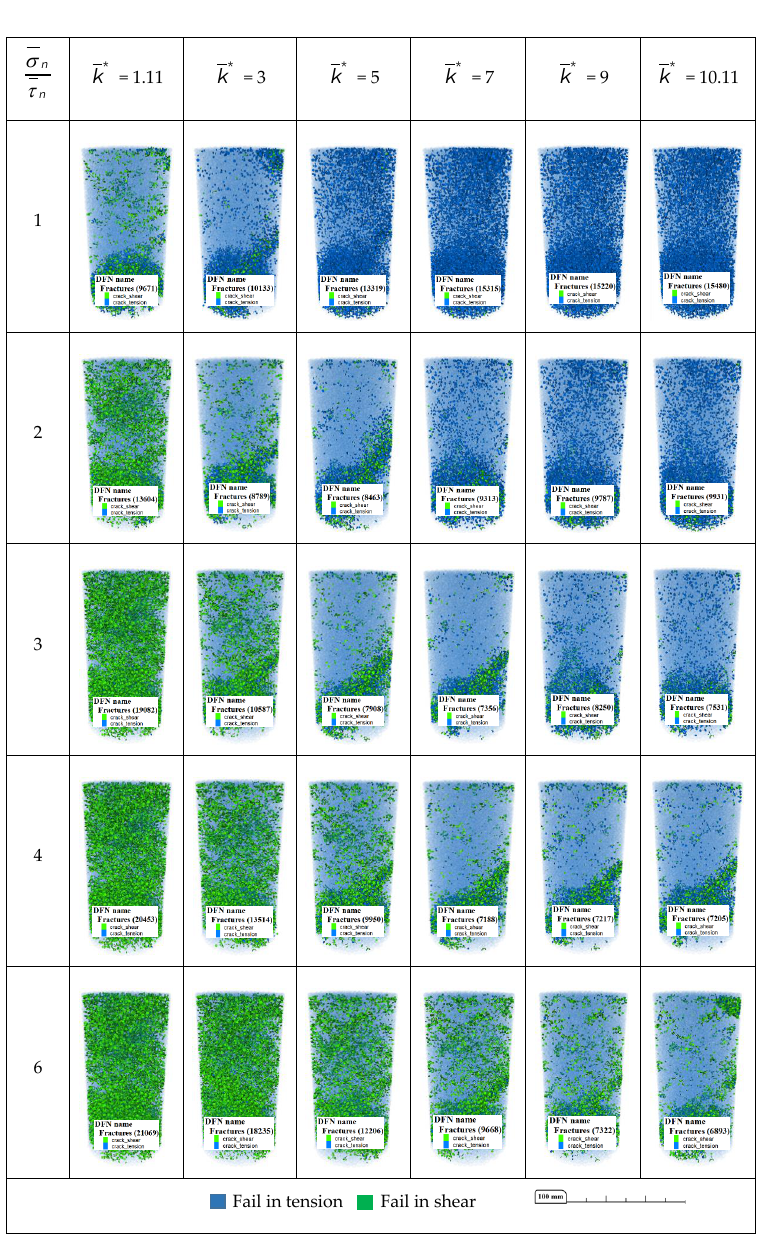
Figure 11. Propagation of micro-fractures in samples with di ff erent bond normal-to-shear sti ff ness ∗ ratios ( k ) for σ n / τ n >